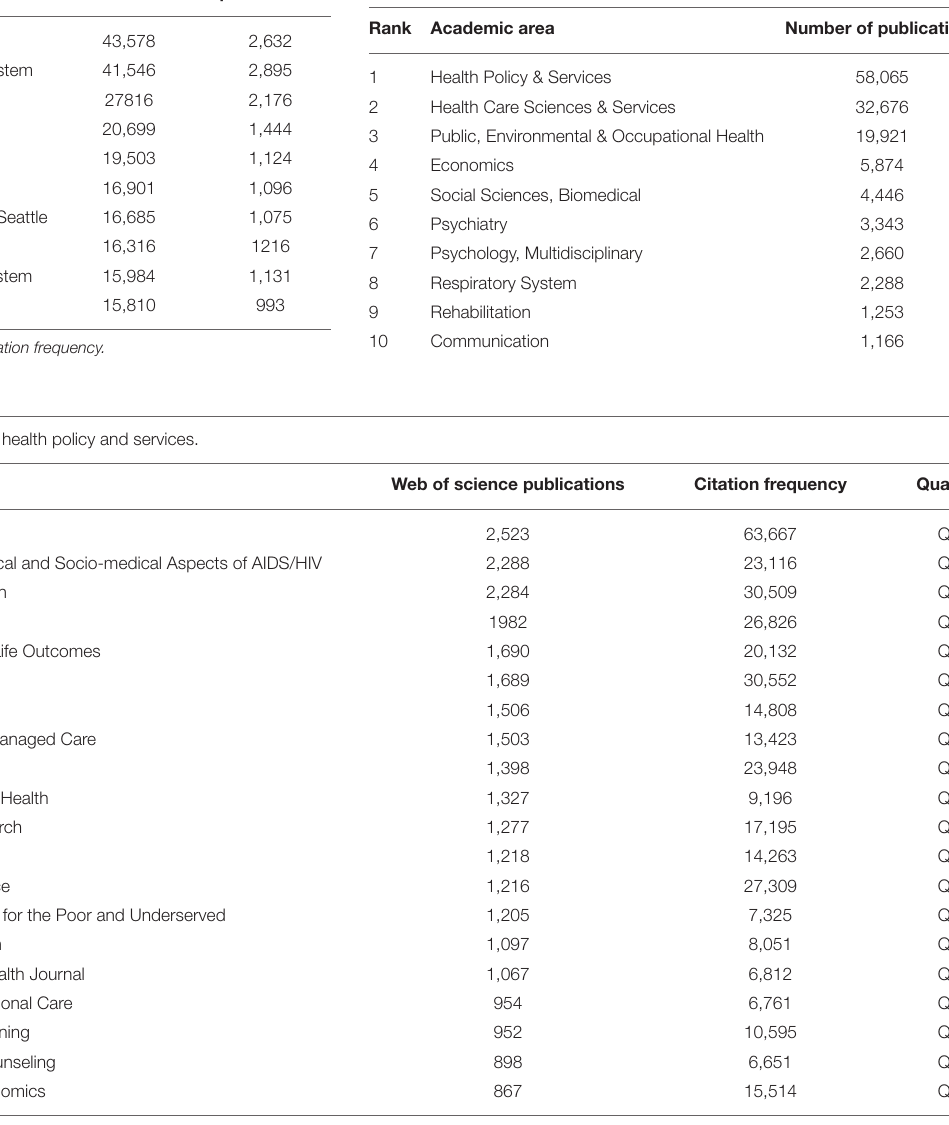
TABLE 3 | Academic areas of health policy and services.